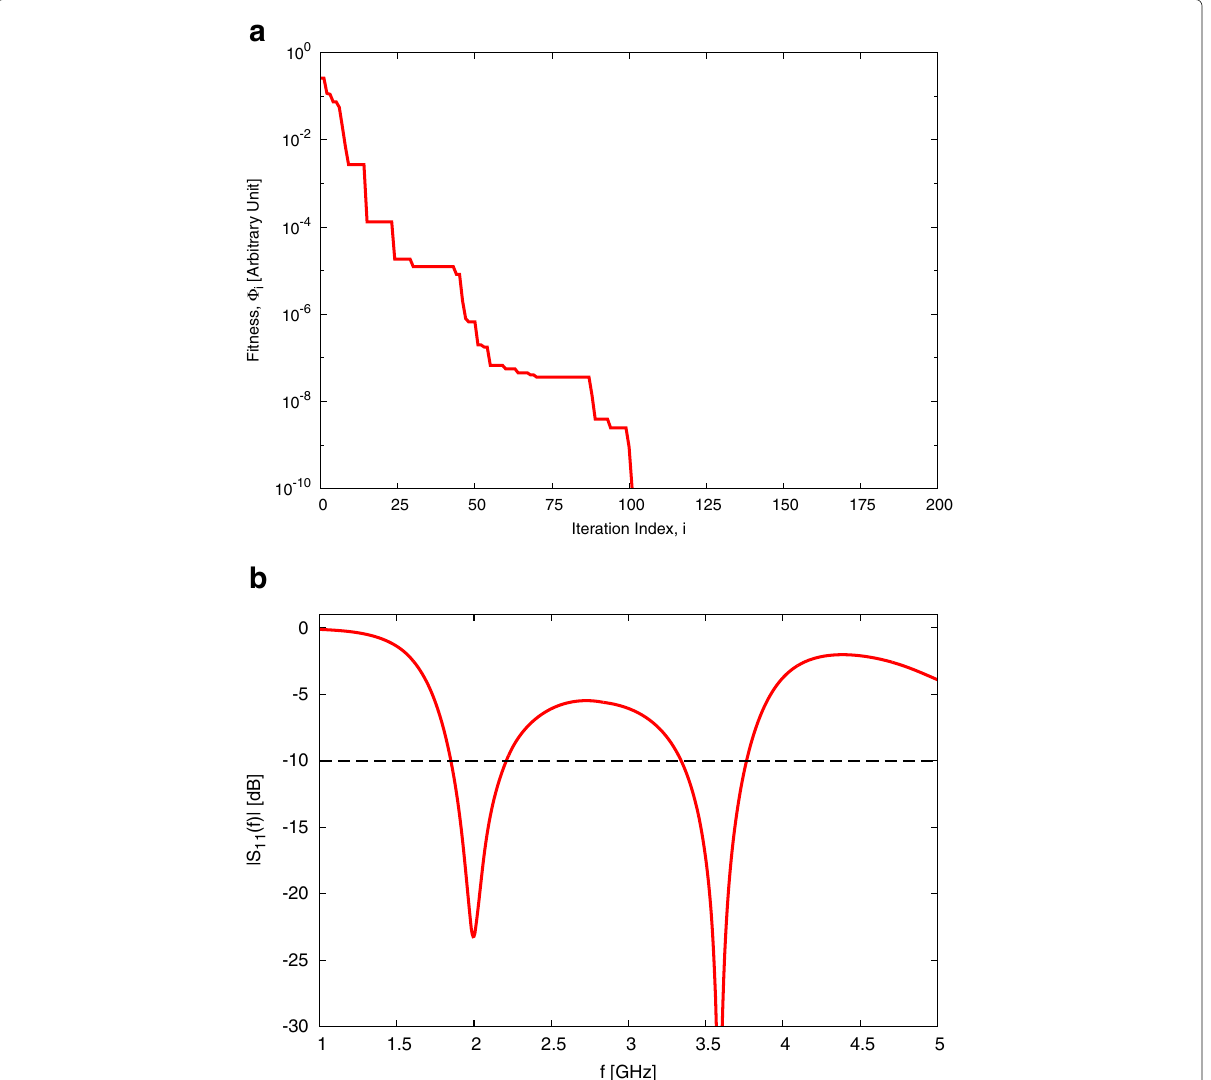
Fig. 4 SbD validation (LTE-2100 and LTE-3500 bands). Behavior of (cid:4) i vs. the SbD iteration index i ( a ) and scattering parameter of the optimized layout vs. frequency ( b )